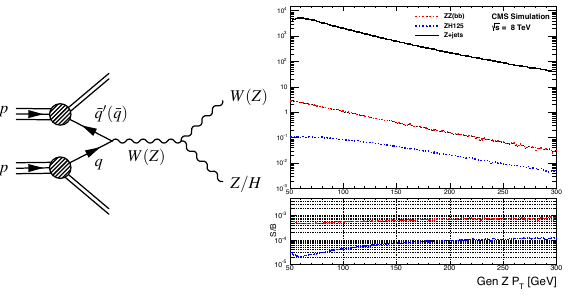
Figure 1. Left, Tree level s-channel Feynman diagram for VZ / VH production at LHC. Right, Di ↵ erential distribution of the generated Z p T for: Z + Jets, ZZ, ZH. The bottom plot contains the ratios ZZ / Z + jets and ZH / Z +